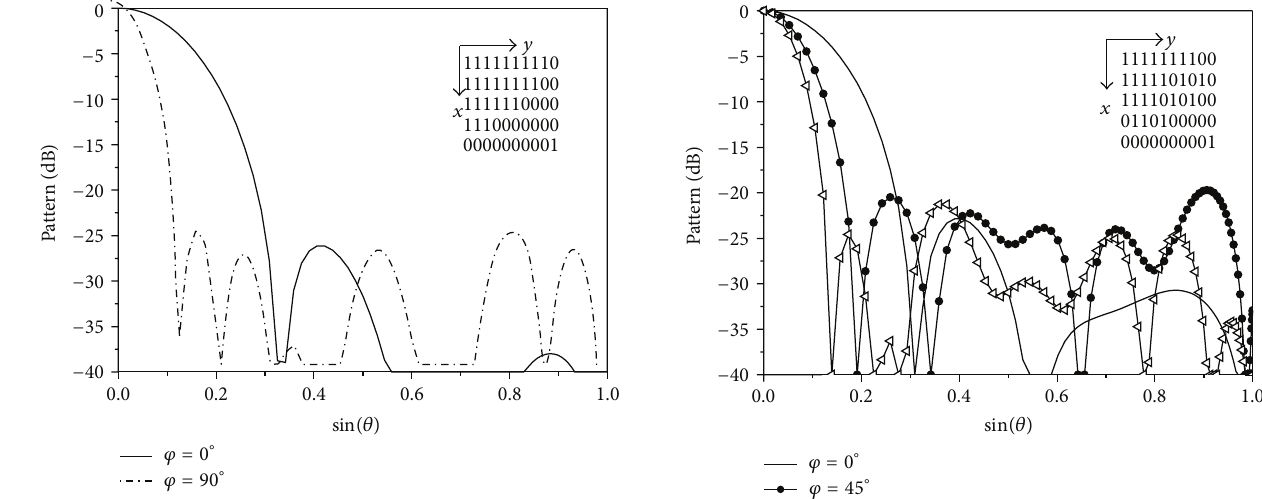
These mistakes were made regarding Figures 1 and 5. They should be replaced by the previous corrected ones.